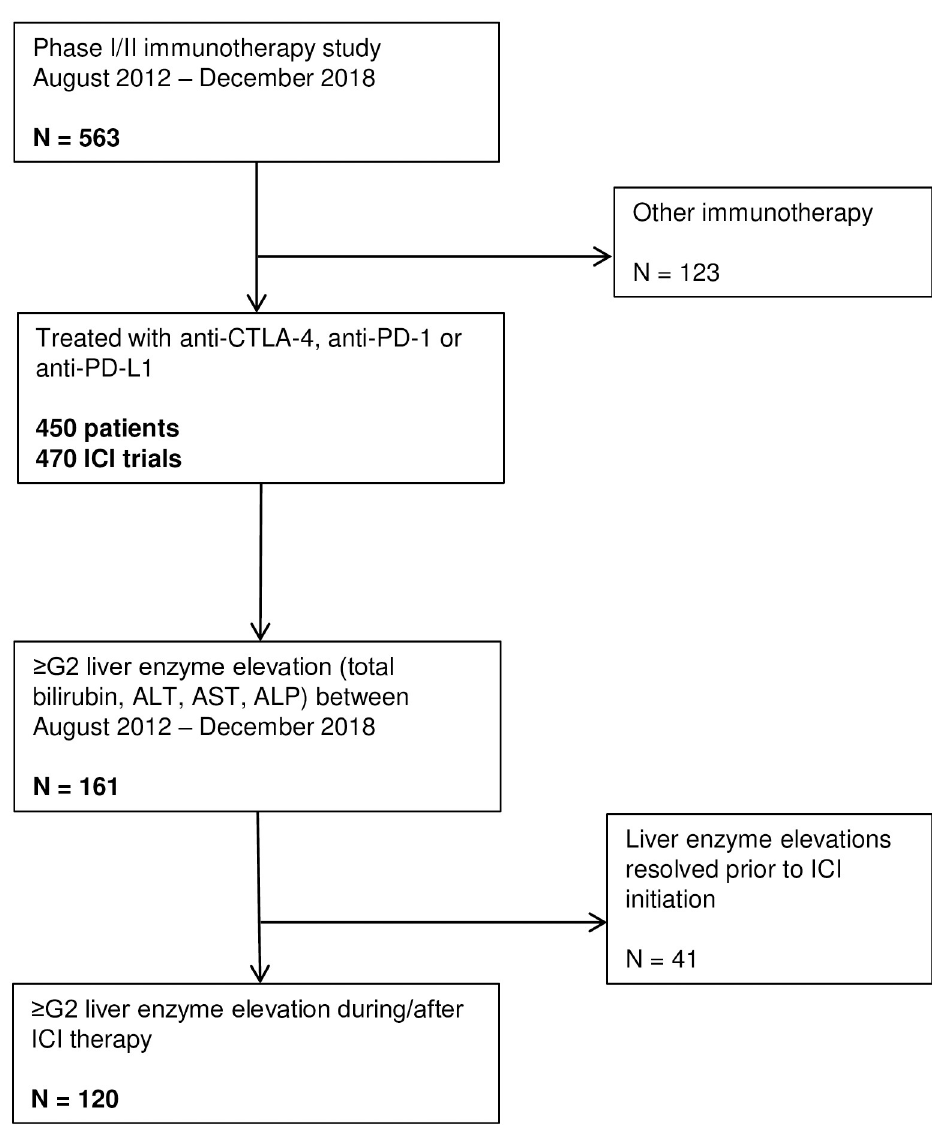
Fig 1. Flow diagram illustrating identification of patients with liver enzyme elevation for inclusion in the study. ICI, checkpoint inhibitor; ALT, alanine aminotransferase; ALP, alkaline phosphatase; PD-1, programmed death protein 1; CTLA-4, cytotoxic T-lymphocyte-associated protein 4; PD-L1, programmed death-ligand 1; ALP, alkaline phosphatase; ALT, alanine aminotransferase; AST, aspartate aminotransferase.